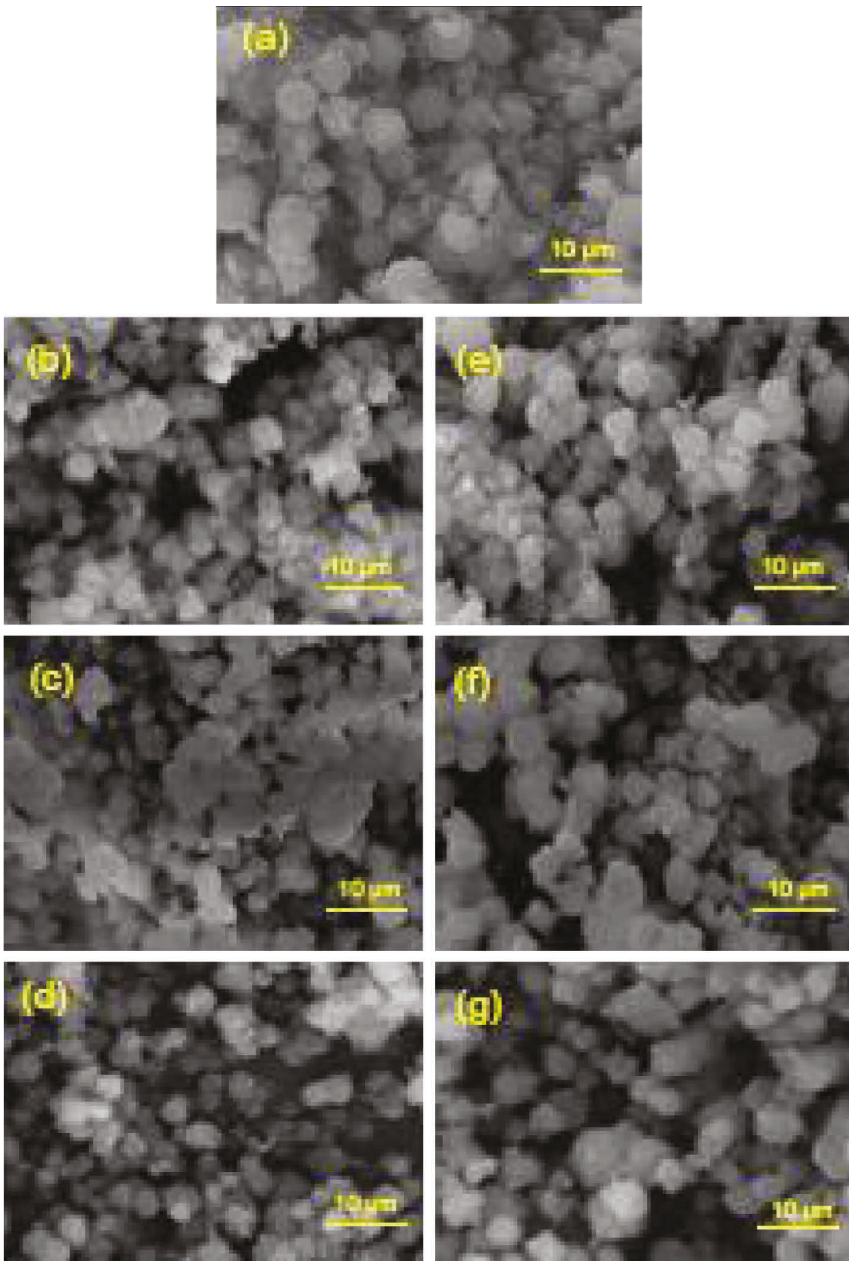
Figure 6: SEM images of catalysts and 13X zeolite: (a) 13X zeolite; (b) Fe/13X zeolite; (c) Co/13X zeolite; (d) Cu/13X zeolite; (e) Fe-Co/13X zeolite; (f) Fe-Cu/13X zeolite; (g) Co-Cu/13X zeolite;